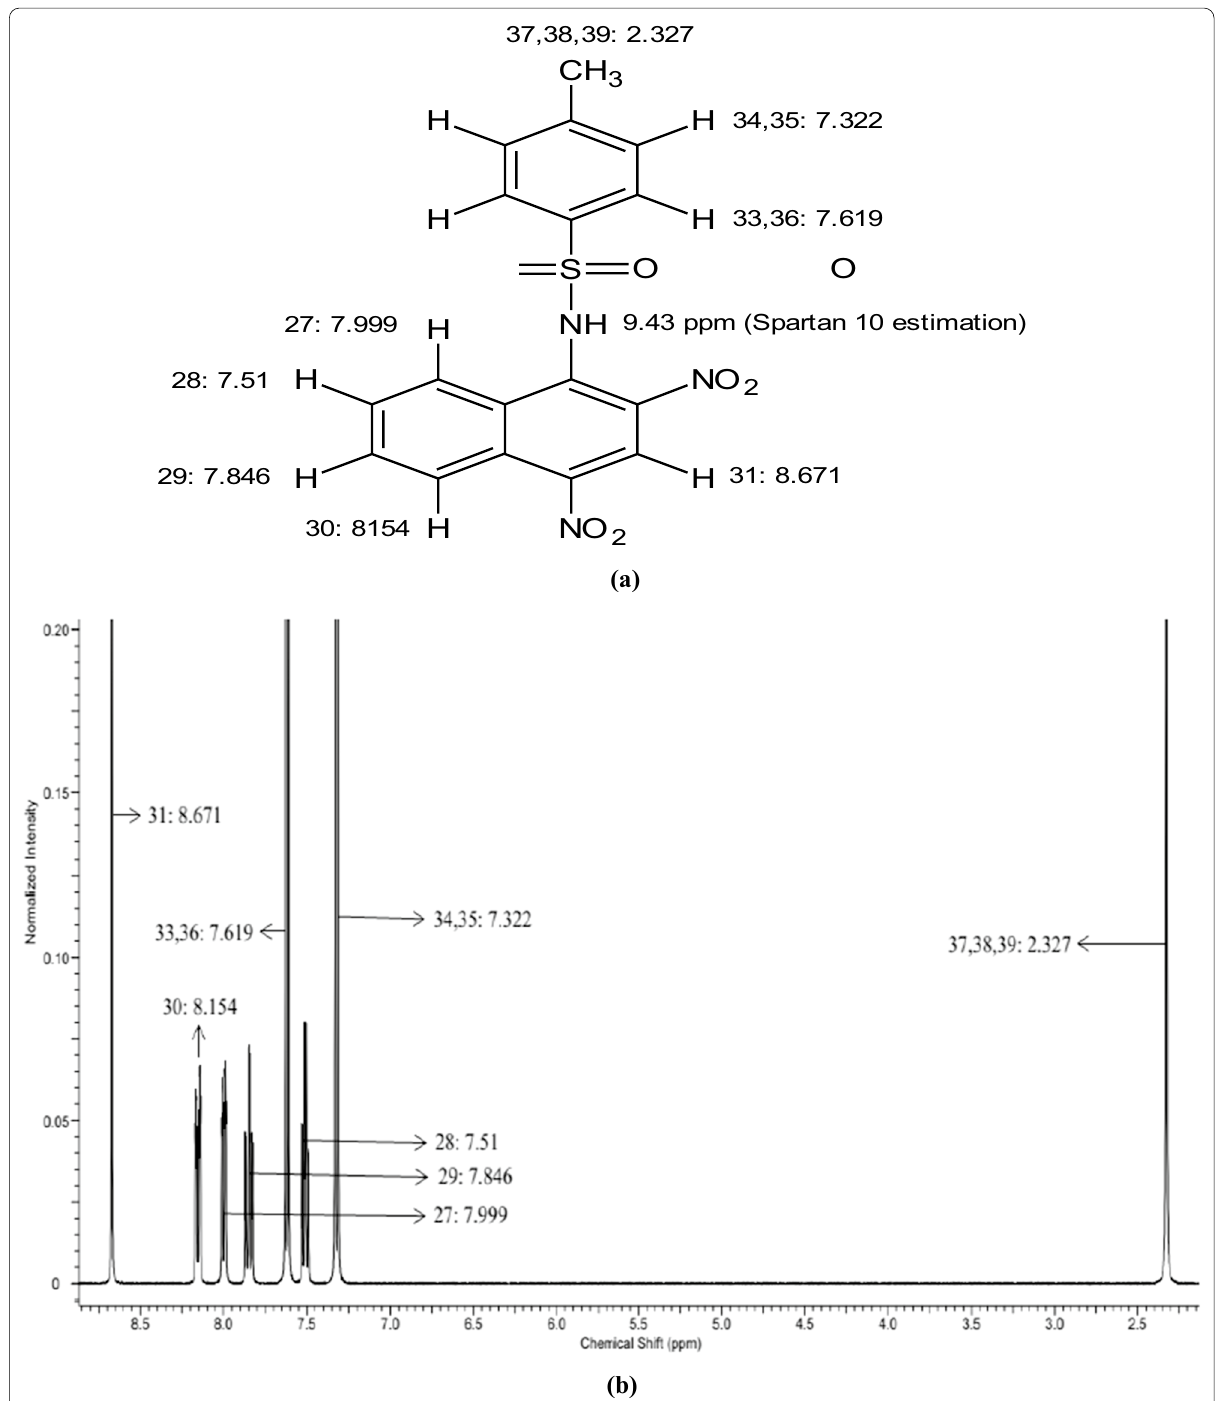
Fig. 7 a Spinus predicted chemical shifts of N-(2,4-DN1NL) PTS arranged according to protons. b Spinus predicted 1 H NMR spectrum of N-(2,4-DN1NL) PTS showing atom ID and chemical